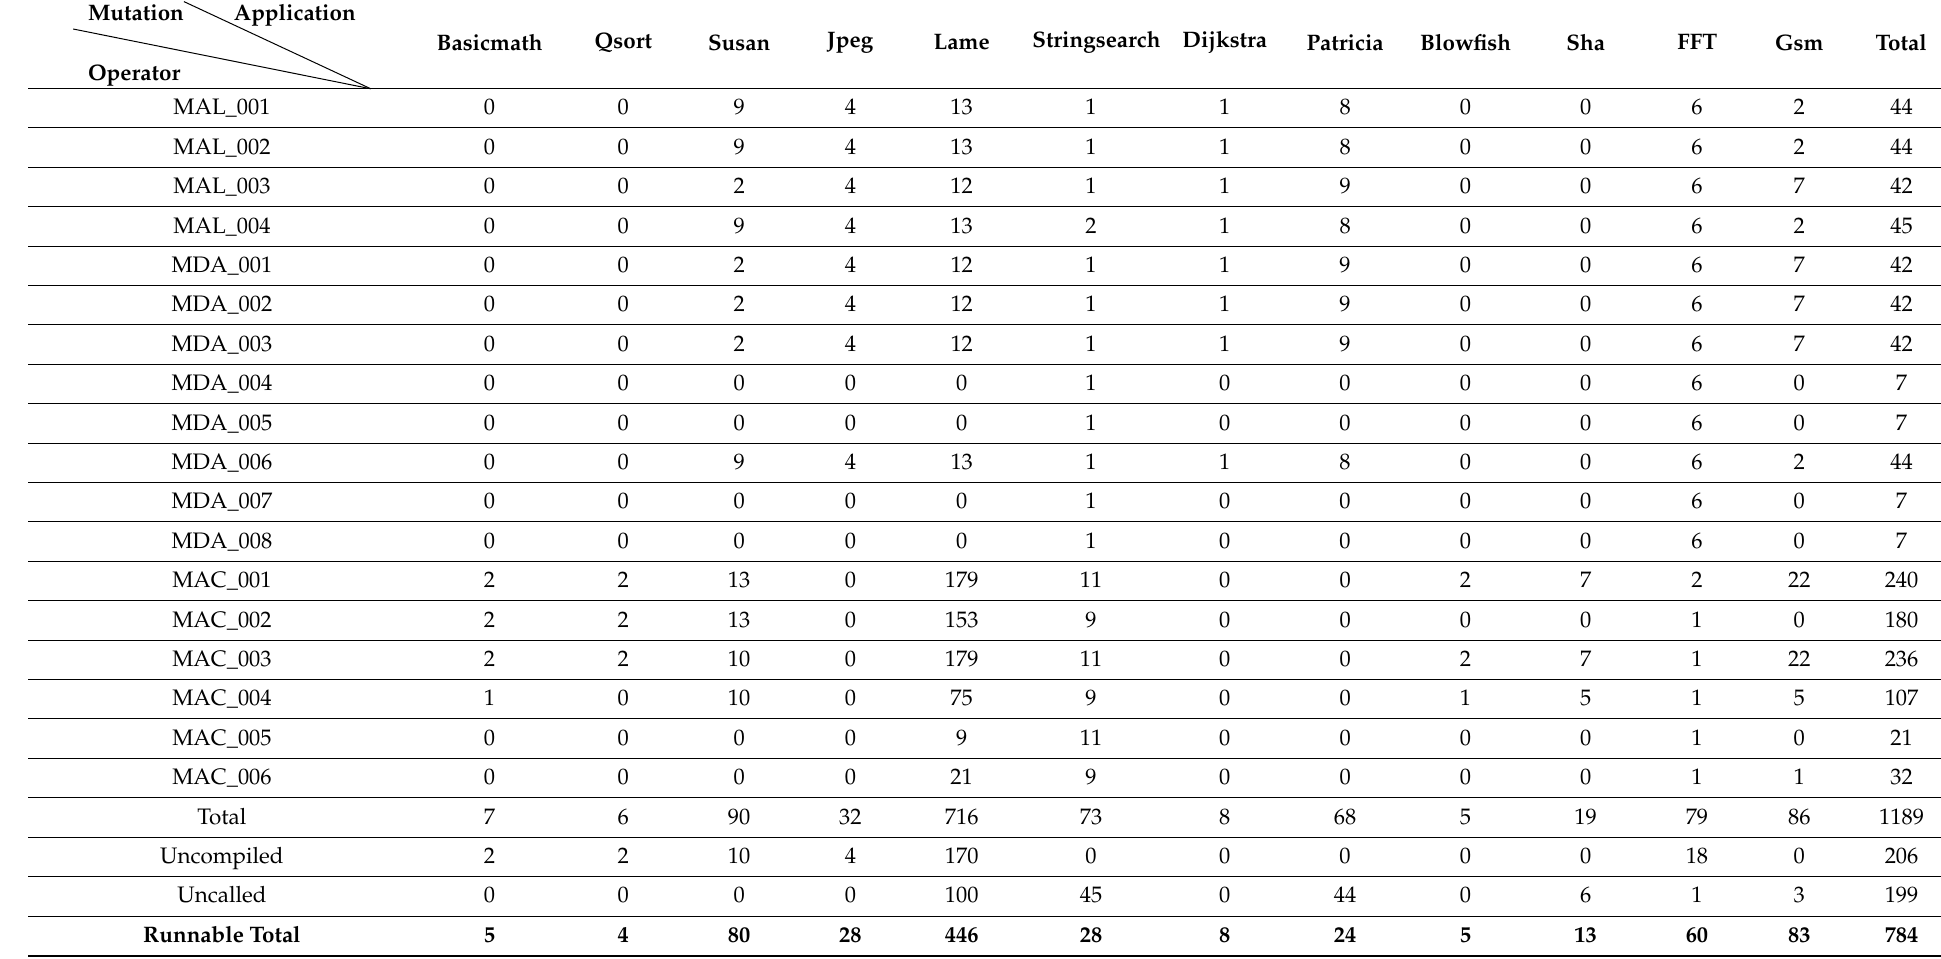
Table 7. Number of mutants per MiBench